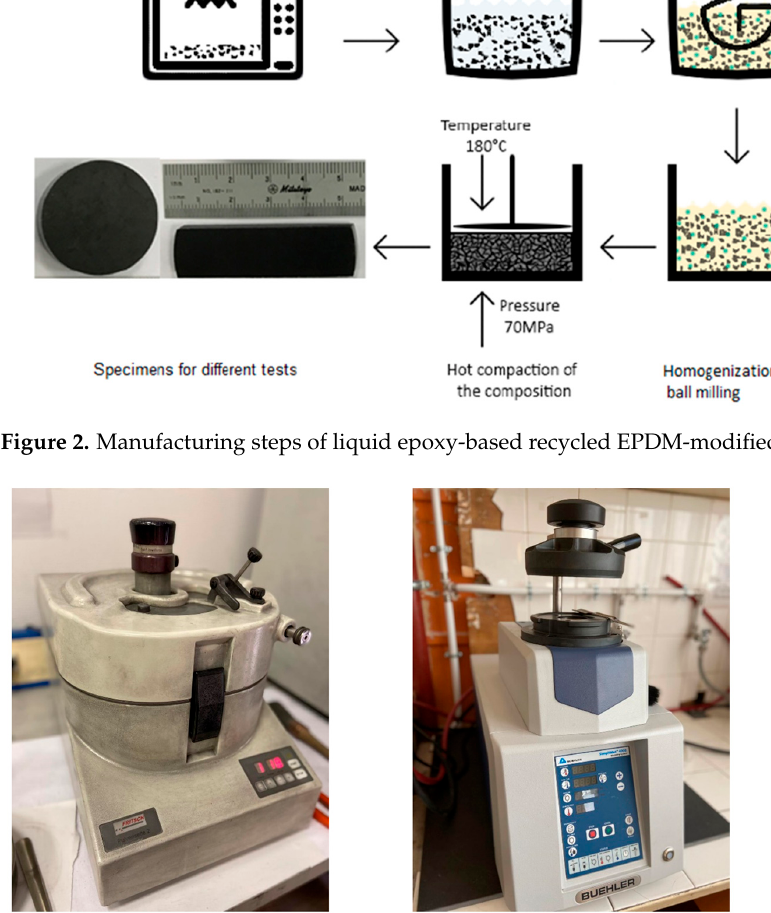
Figure 3. Milling (left) and hot compaction (right) of the mixture. Figure 3. Milling ( left ) and hot compaction ( right ) of the